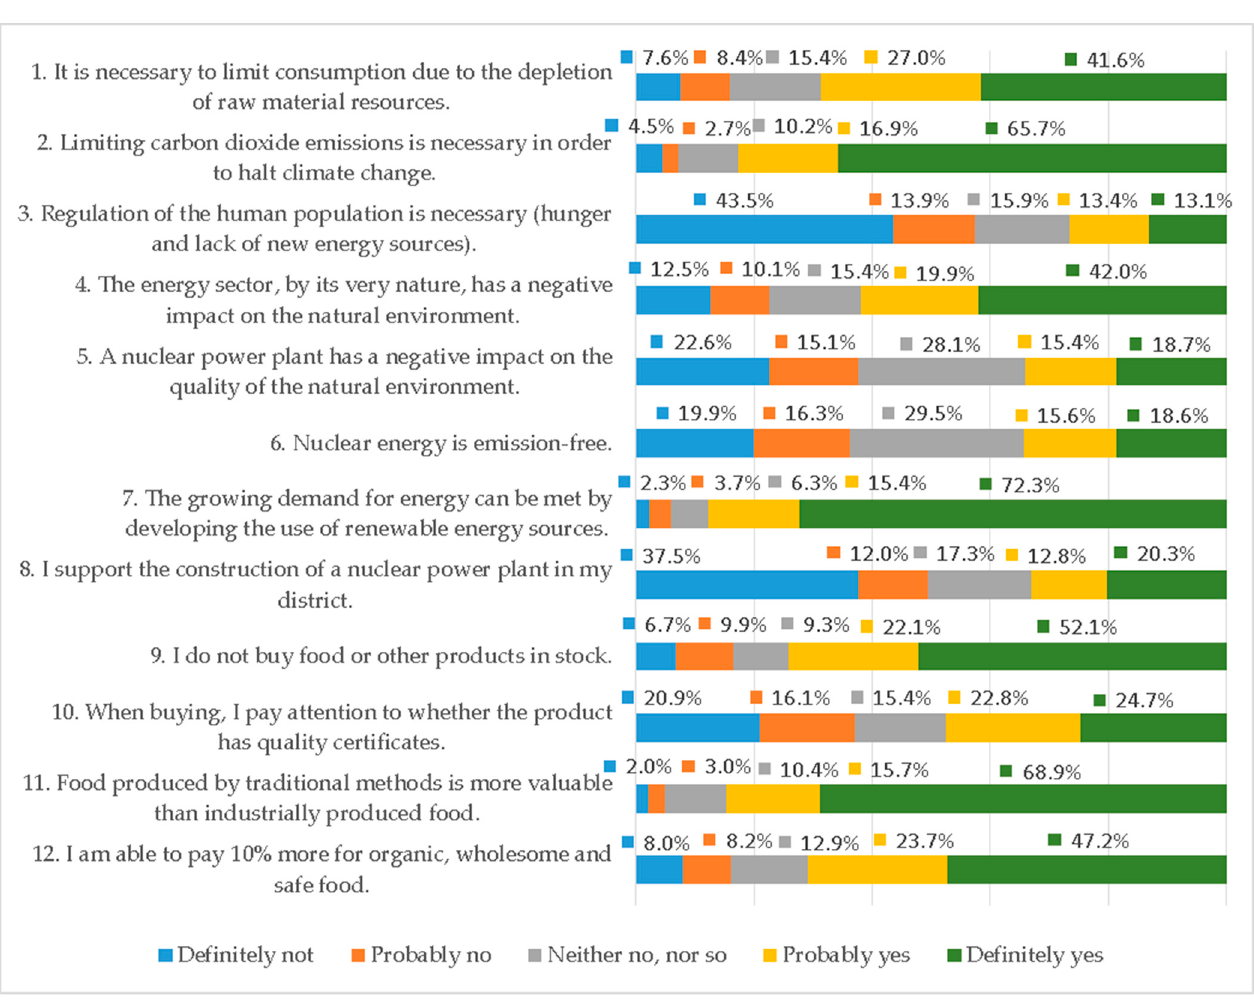
Figure 6. The structure of assessments of theses diagnosing attitudes and perception of the studied phenomena by adult respondents.